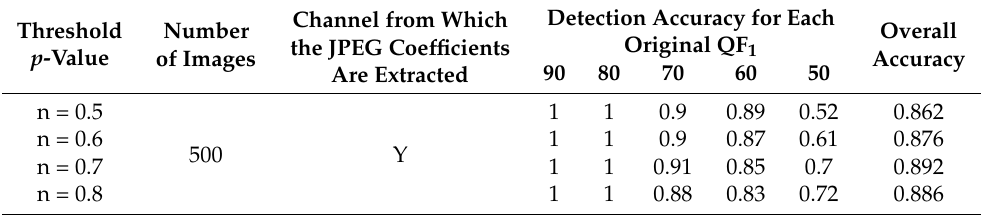
Table 6. The algorithm results for different threshold p -values, using Y